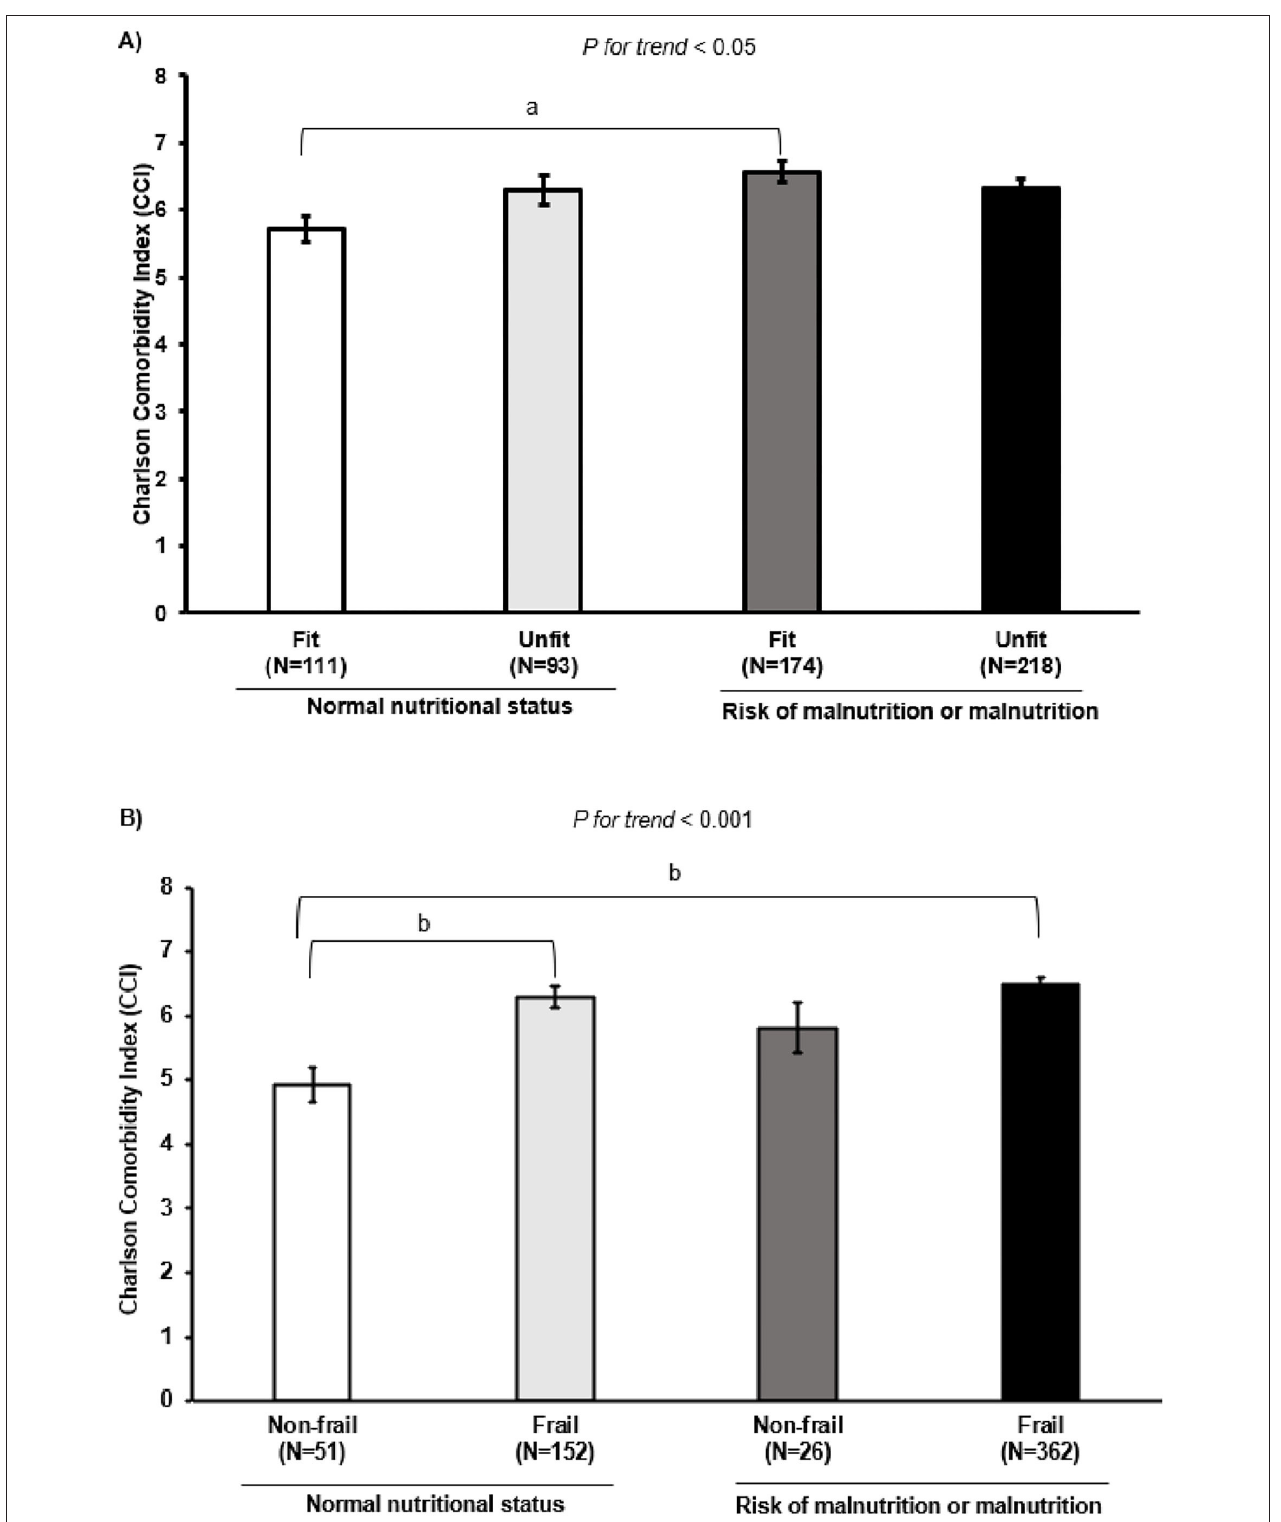
FIGURE 3 | Differences among comorbidity risk according to the nutritional status combined with several physical parameters. (A) Nutritional status combined with fitness categories assessed by handgrip strength (kg) [ ≤ P25 unfit, (36)]. (B) Nutritional status combined with frailty categories (SPPB score ≤ 9 frail). Unadjusted analysis of variance (polynomial). a p < 0.005; b p <